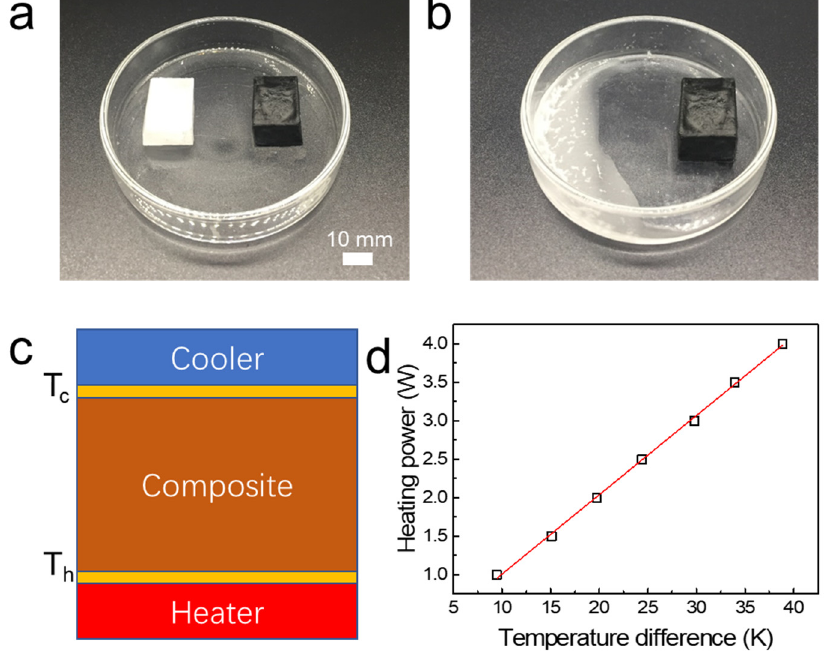
Figure 3. Form stability and thermal conductivity of the PCM composite. ( a ) Photograph of the PCM composite sample and paraffin sample before heating. ( b ) Photograph of the two samples after heating. ( c ) A schematic of the setup for differential steady state method. ( d ) Measurement result of the PCM composite. Table 1. Comparison of the prepared PCM composite with other reported works.